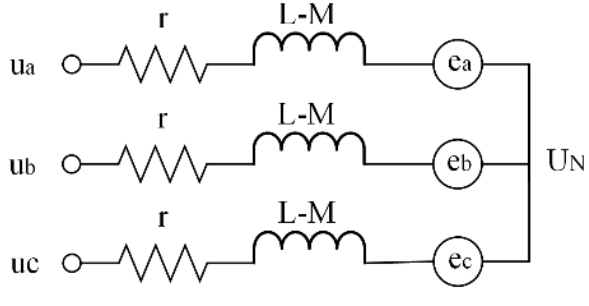
Figure 7. Equivalent circuit diagram.